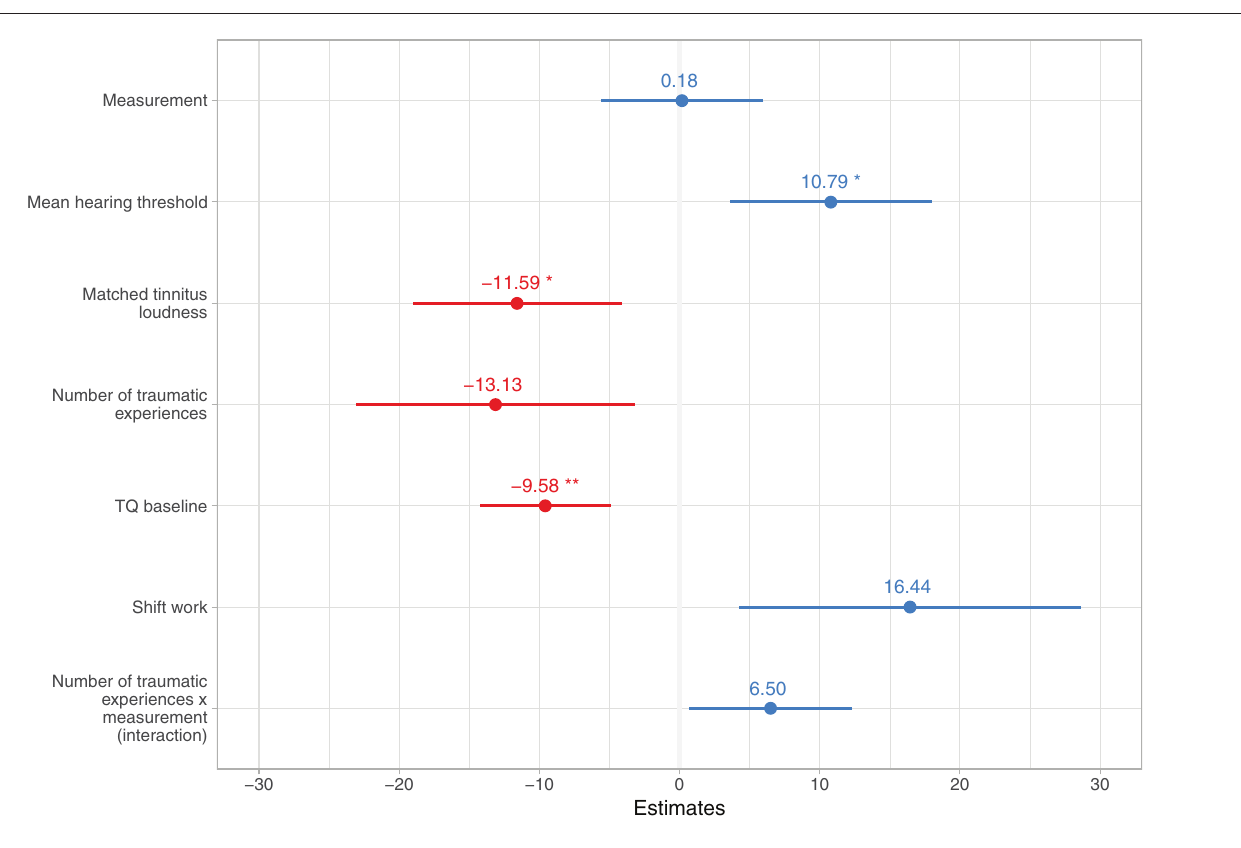
FIGURE 4 | Reduced linear mixed-effects model with stepwise backward elimination ( N = 80) for change in hair-BDNF levels across baseline and follow-up ( N = 80). Numbers indicate estimated coefficient effects and lines depict 95% confidence intervals. Significance levels are displayed after adjustment for multiple testing with Holm’s method. TQ, Tinnitus Questionnaire. * p < 0.05; ** p <